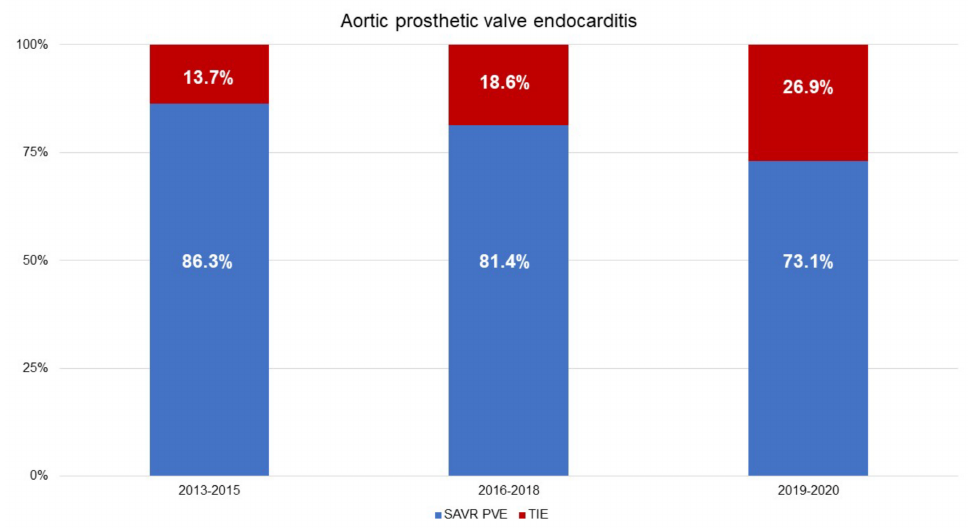
Figure 2. Temporal distribution of aortic prosthetic valve endocarditis with the distribution of SAVR–PVE and TIE. (Data are expressed as percentages.) SAVR–PVE, prosthetic valve endocarditis following surgical aortic valve replacement; TIE, prosthetic valve endocarditis following transcatheter aortic valve